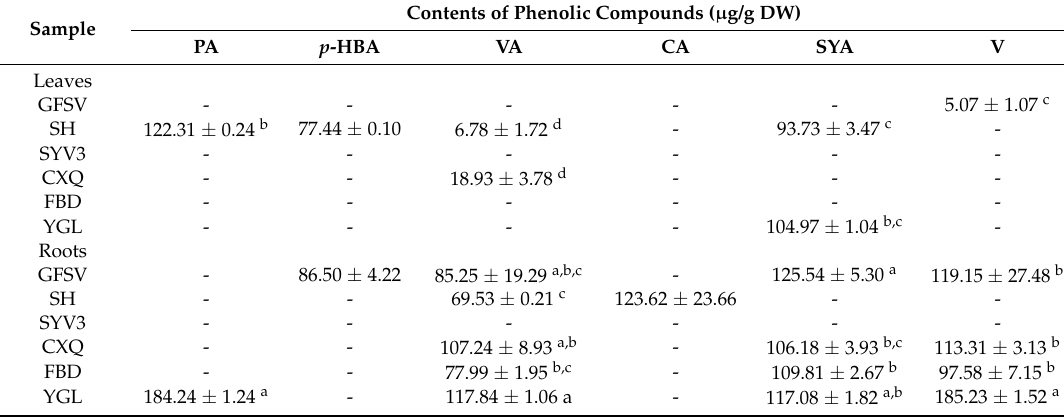
Table 4. Phenolic compounds of conjugate extracts of Phal. hybrids base on: PA, p -BHA, VA, CA, SYA, and